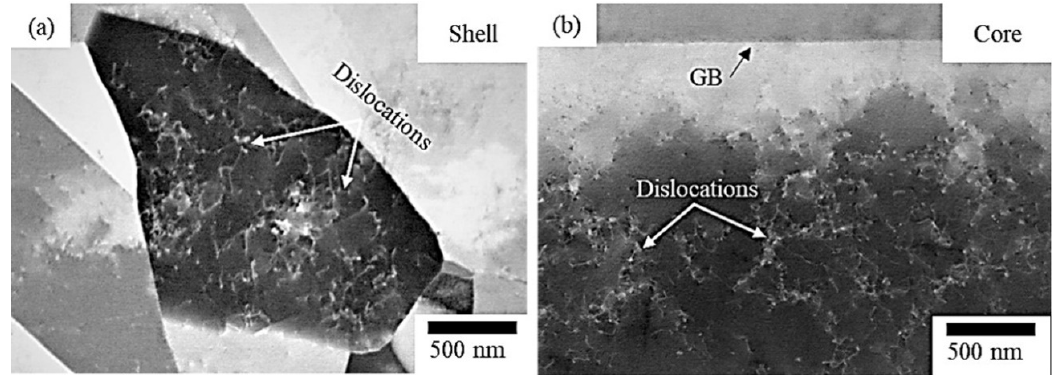
Figure 10. ECCI of pure Ni HS after 5% tensile deformation. ( a ): shell and ( b ): core.